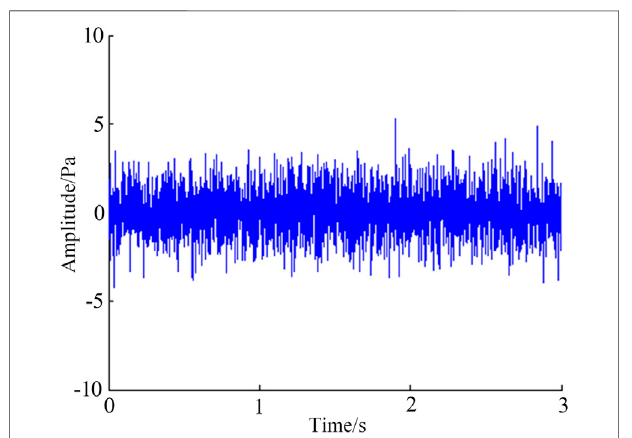
FIGURE 6 | Waveform after denoising by